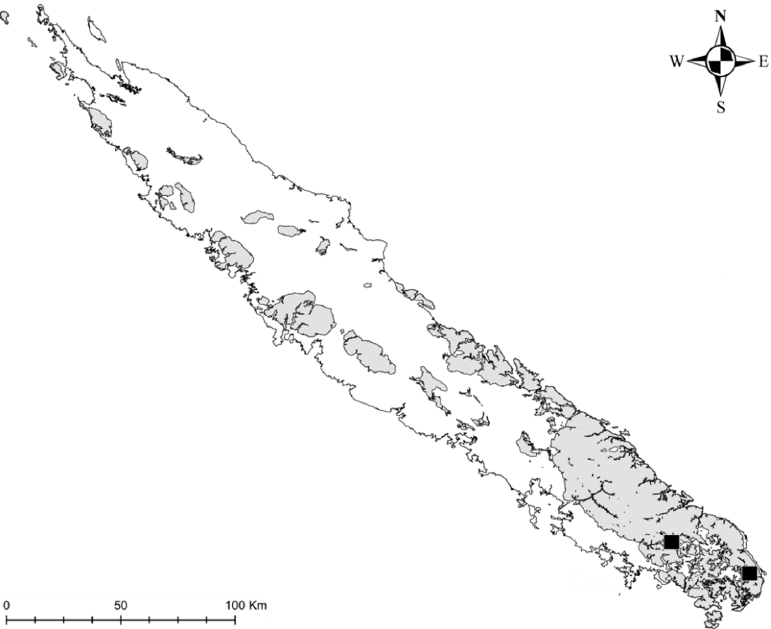
Figure 2. Distribution of Argophyllum riparium Pillon and Hequet (squares). Grey areas indicate ultramafic rocks.